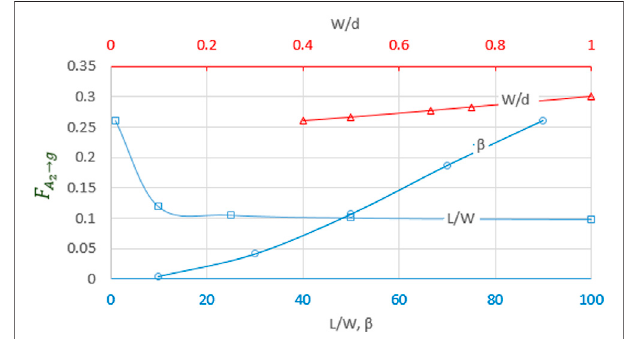
FIGURE 11 | In fl uence of solar fi eld design parameters on F A